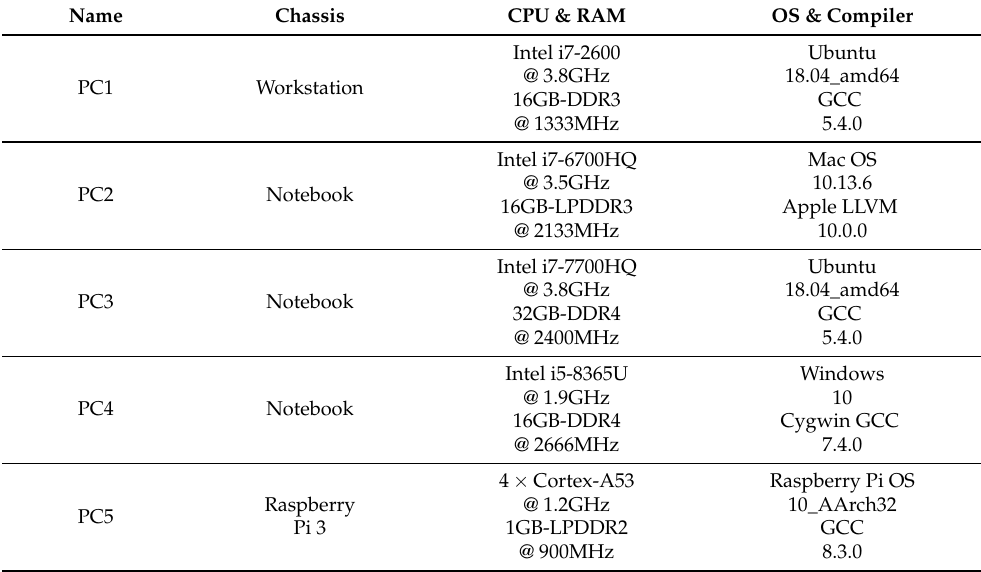
Table 4. PCs used for performance